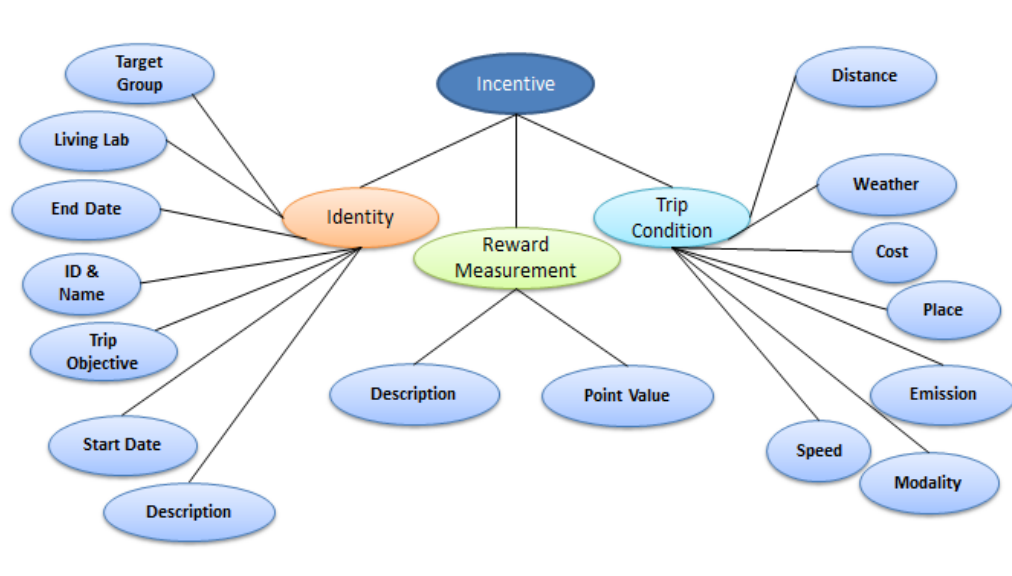
Figure 3. Incentive Data